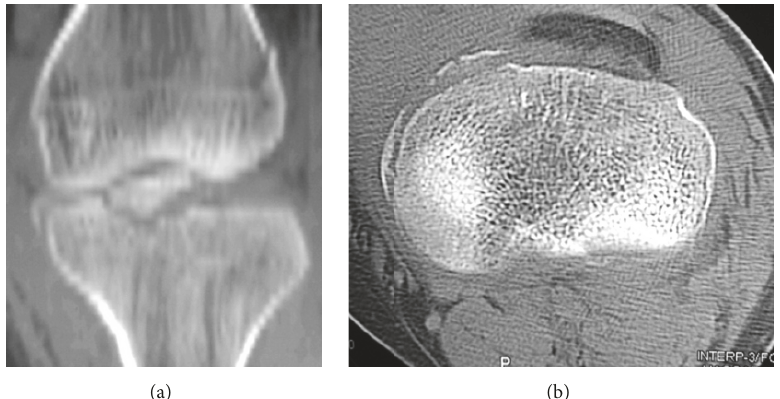
Figure 2: Computed tomography: (a) coronal image showing tibial eminence and reverse Segond fractures and (b) axial image showing reverse Segond and anteromedial rim